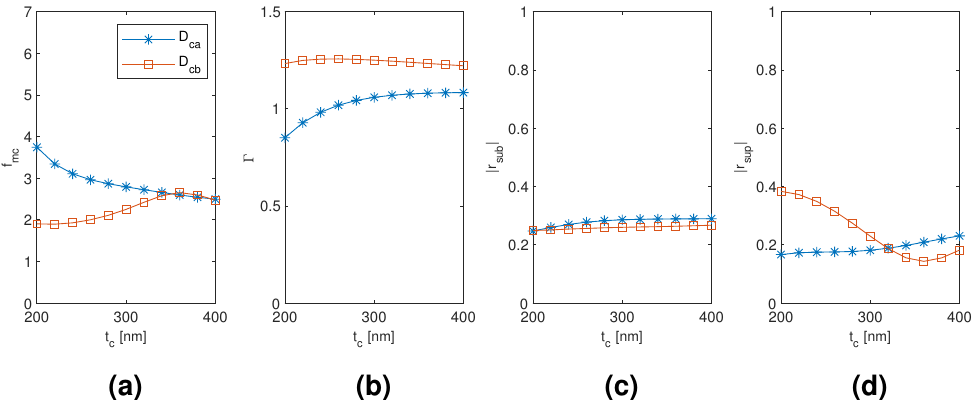
Figure 13. The results for the coated dimer D ca and D cb mode as a function of the coating thickness with the diameter and separation of the nanowires corresponding to the point of modal cost function minimum for each mode (as listed in Table 2). ( a ) modal cost function value; ( b ) modal confinement factor; ( c ) substrate modal reflection coefficient magnitude; ( d ) superstrate modal reflection coefficient